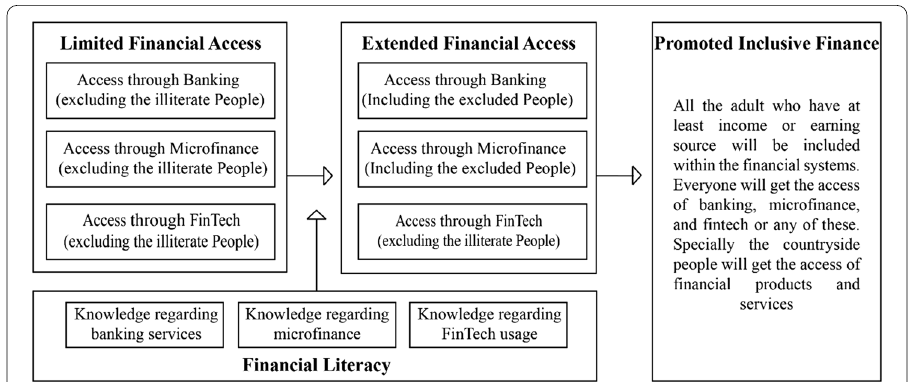
Fig. 1 Theoretical framework. Source : Author’s